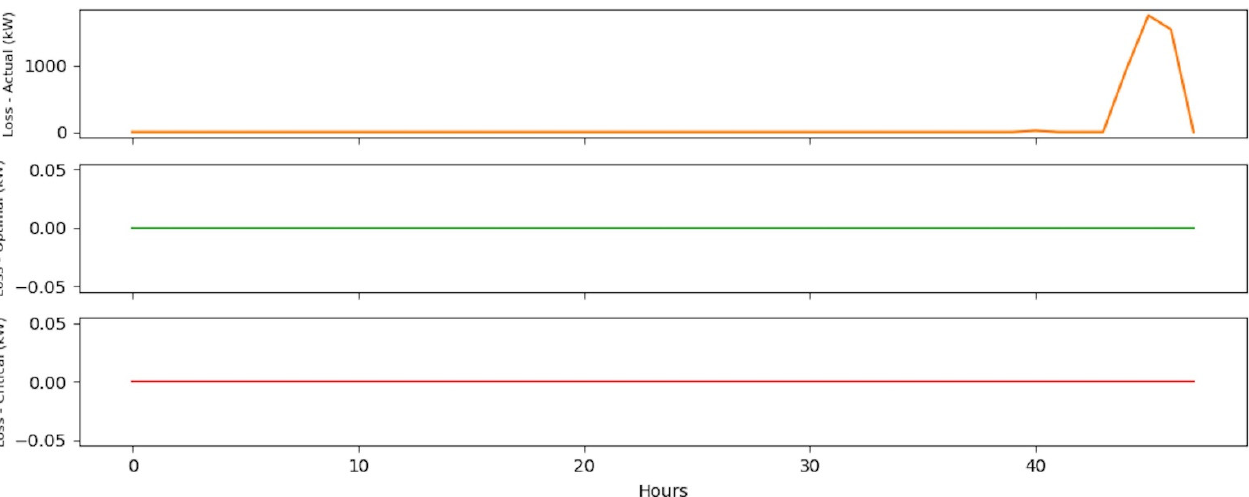
Figure 5. Loss occurrence and value in winter.